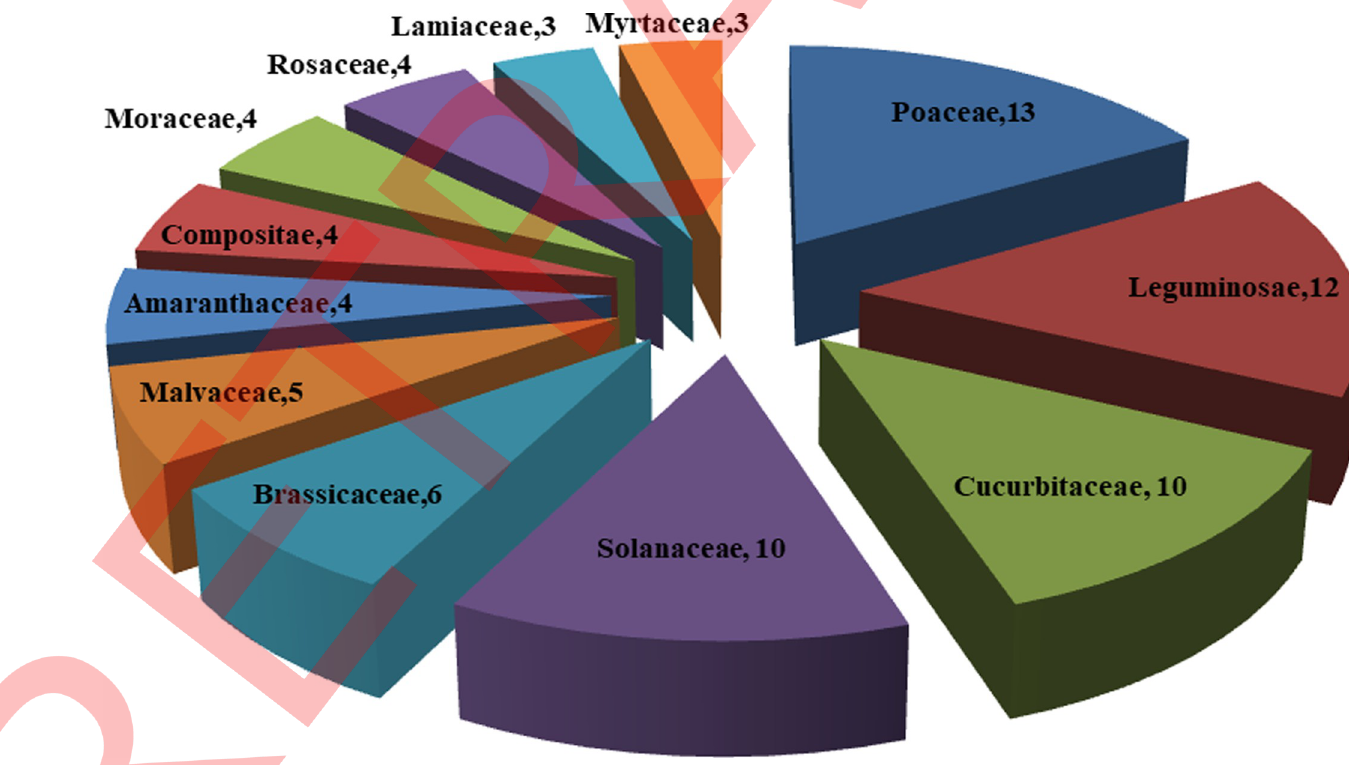
Fig 1. Contributions of top 12 families in ethnobotanical flora of Mandi Ahmad